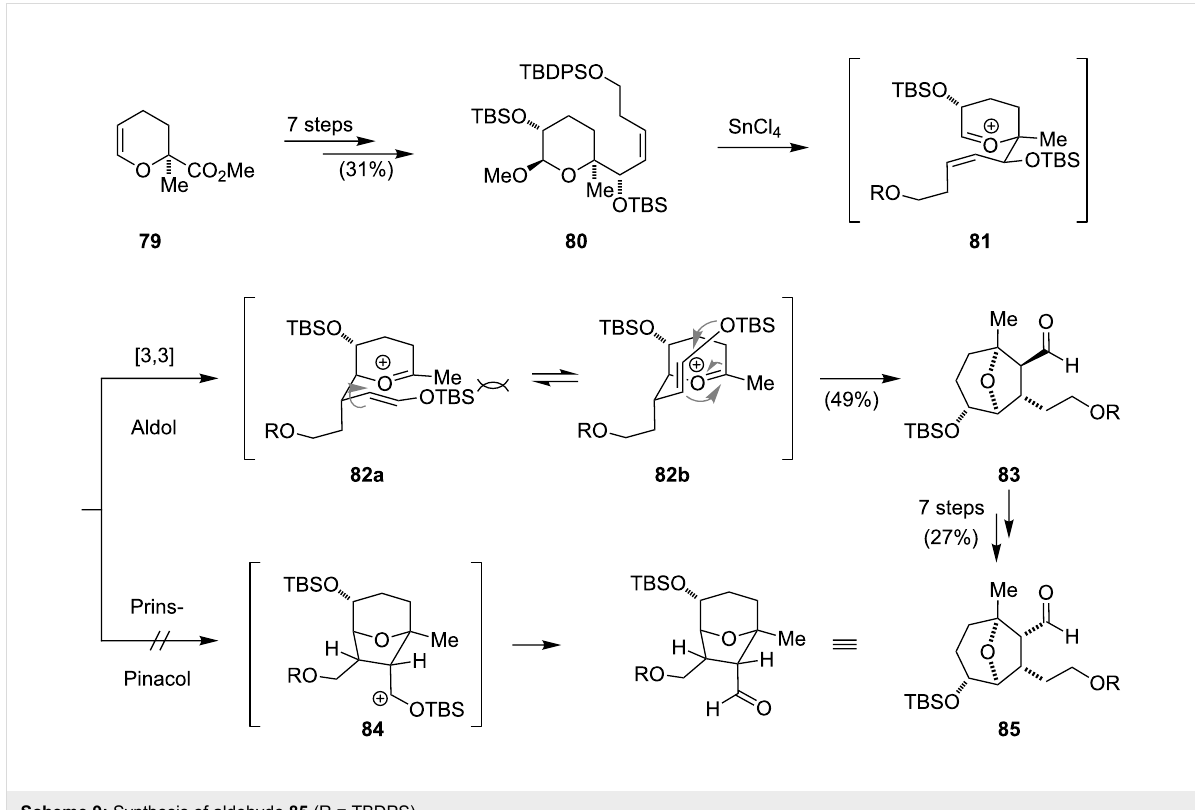
Scheme 9: Synthesis of aldehyde 85 (R =